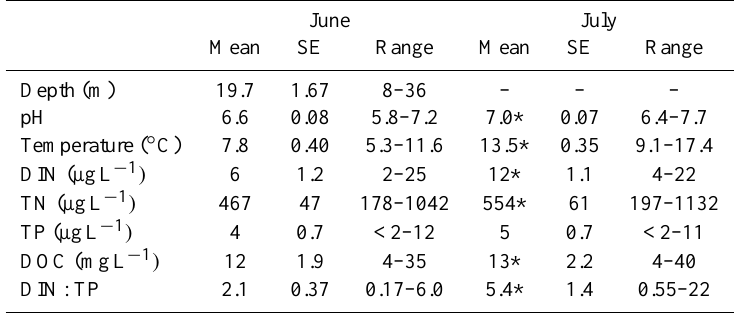
Table 1. Epilimnetic physical and chemical data across the 24 lakes in June and July 2013. Significant changes ( p ≤ 0.05) between June and July means are indicated by asterisk (*). Depth was not measured in July. SE: standard error.